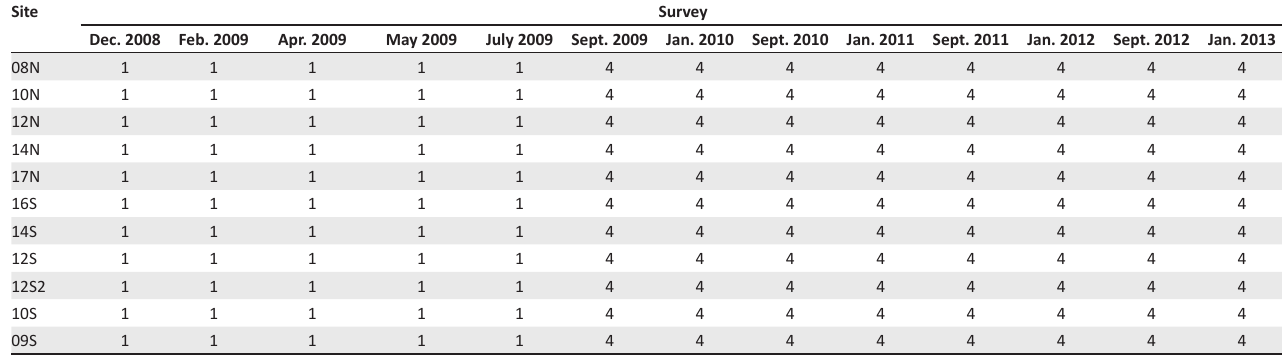
TABLE A1: Summary of the number of replicates set out at each of the 11 sites during each of the 13 surveys along the Soutpansberg Mountain Range. A replicate within a site consisted of 10 pitfalls in a 2 × 5 grid. Pitfalls were separated by 10 m and replicates within a site were separated by at least 300 m to ensure independence. Site Survey